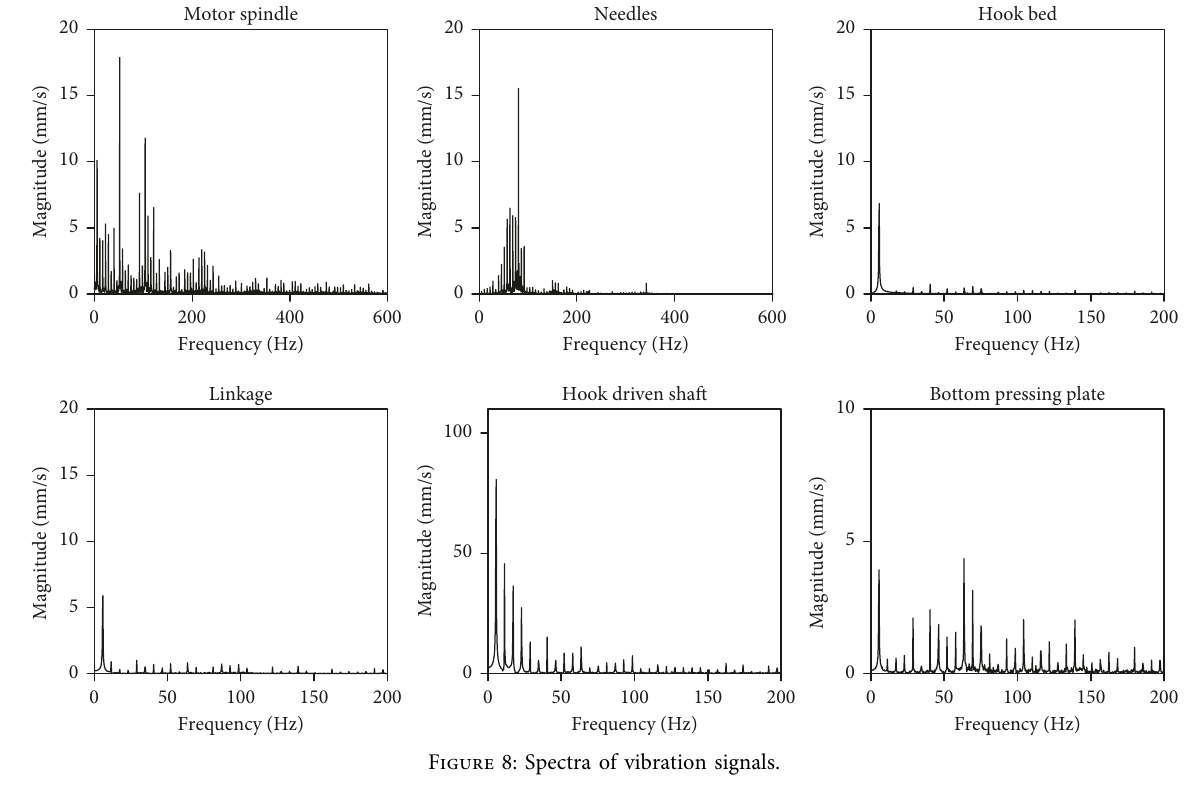
Figure 8: Spectra of vibration signals.